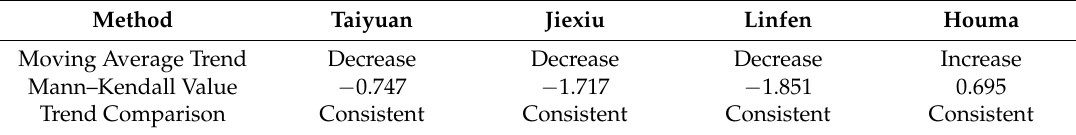
Table 3. Trend analysis of four meteorological stations from 1954 to 2011.